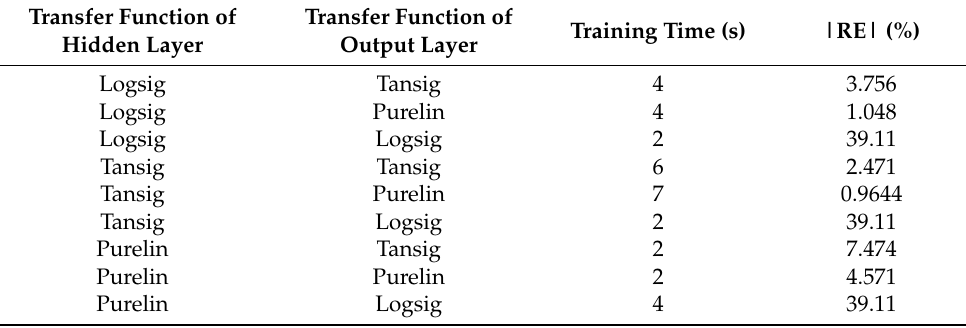
Table 2. Performance of BP neural network using different transfer